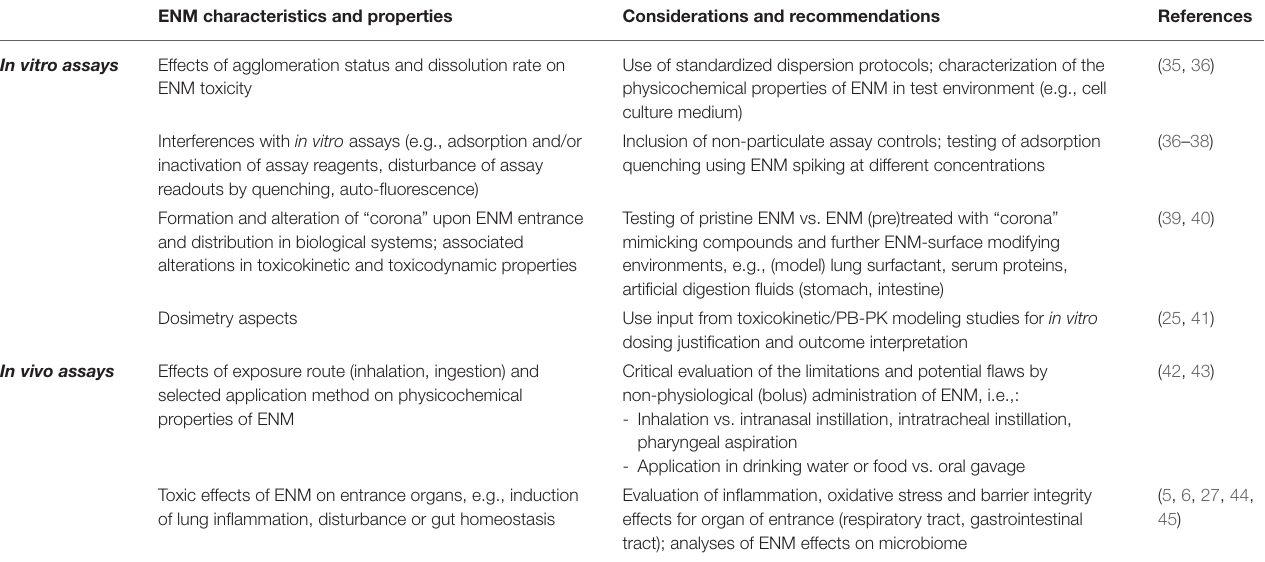
TABLE 1 | ENM neurotoxicity testing